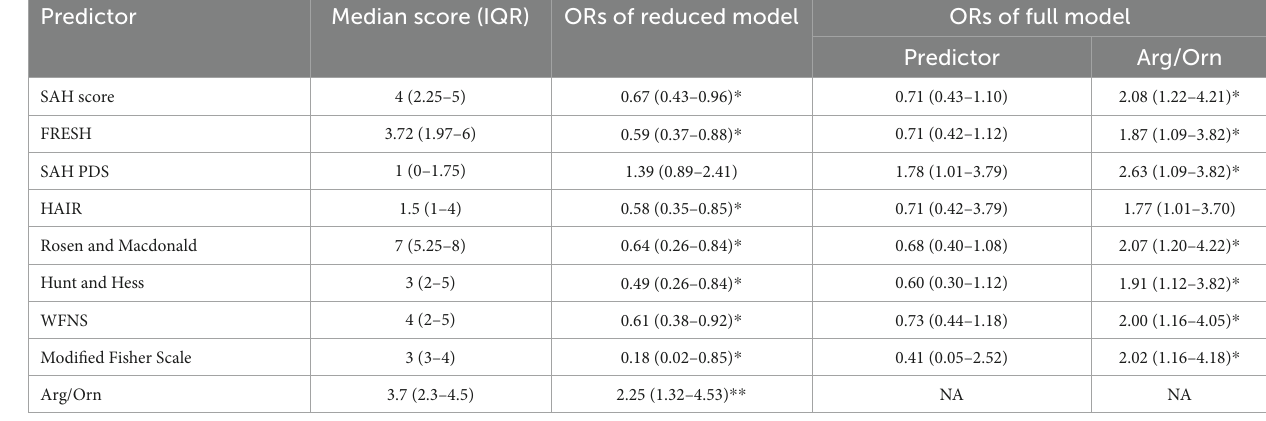
TABLE 2 Odds ratios with 95% confidence intervals for the respective predictors derived from uni- and multi-variable regression models for the prediction of favorable neurological outcome in SAH patients.